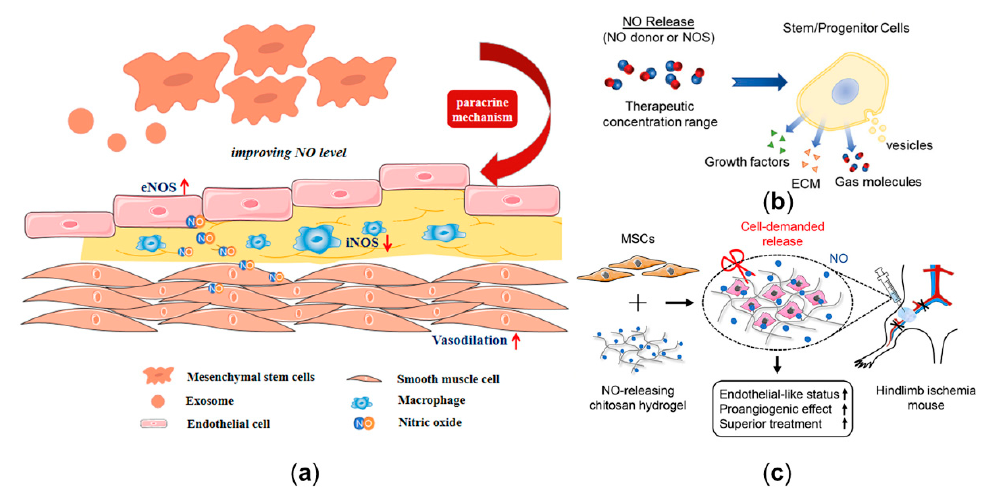
Figure 5. Nitric oxide (NO) delivery-related potential stem cell therapy. ( a ) The protective role of mesenchymal stem cells and exosomes in CVD by improving the eNOS expression of the endothelium and decreasing the iNOS expression of the macrophages. ( b ) The effect of NO release on stem cells. ( c ) The combination of mesenchymal stem cells with NO-release chitosan hydrogel-enhanced therapeutic function in hindlimb ischemia. Panel ( b ) is adapted with permission from Reference [27] , Wiley Online Library. Panel ( c ) is adapted with permission from Reference [157] , Elsevier.